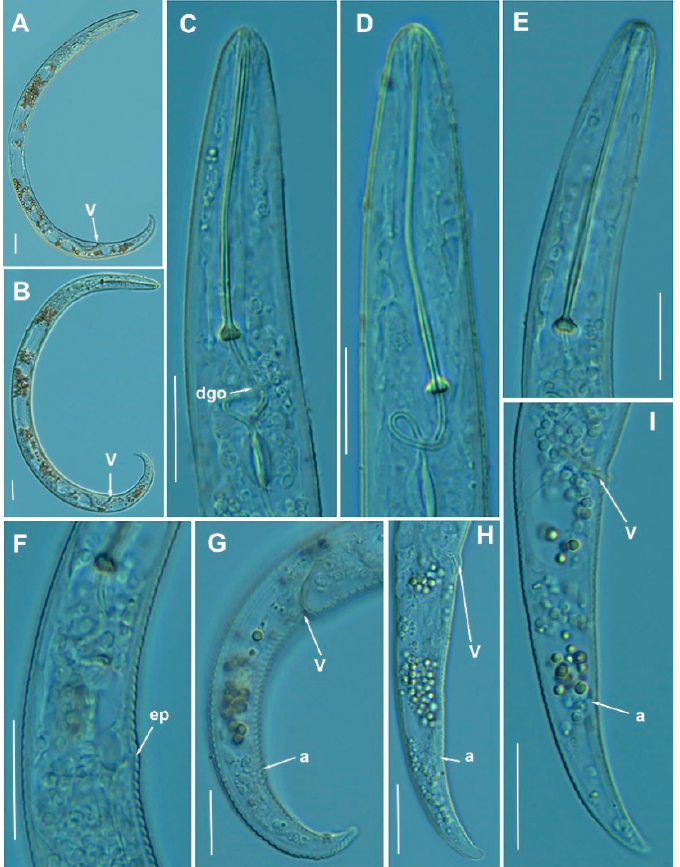
Figure 13. Light photomicrographs of Paratylenchus goodeyi (Oostenbrink, 1953) Raski, 1962. ( A , B ): Entire female with vulva arrowed; ( C – E ): Female lip region; ( F ): Detail of excretory pore; ( G – I ): Female posterior region with vulva and anus (arrowed). Scale bars ( A – I = 20 µ m). (Abbreviations: a = anus; dgo = pharyngeal dorsal gland orifice; ep = excretory pore; V =